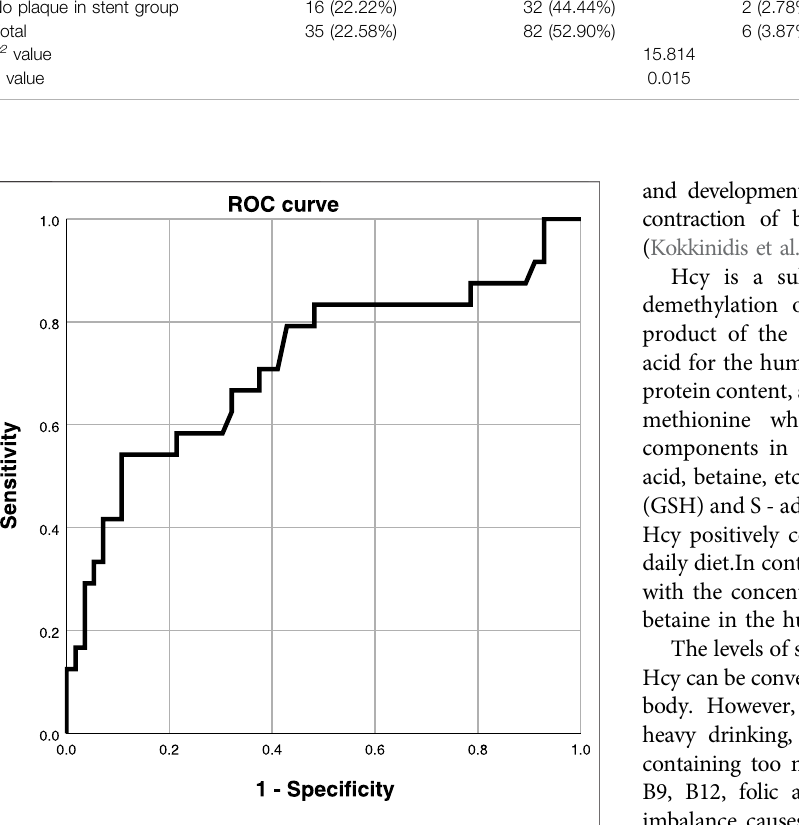
FIGURE 4 | ROC curve of serum Hcy